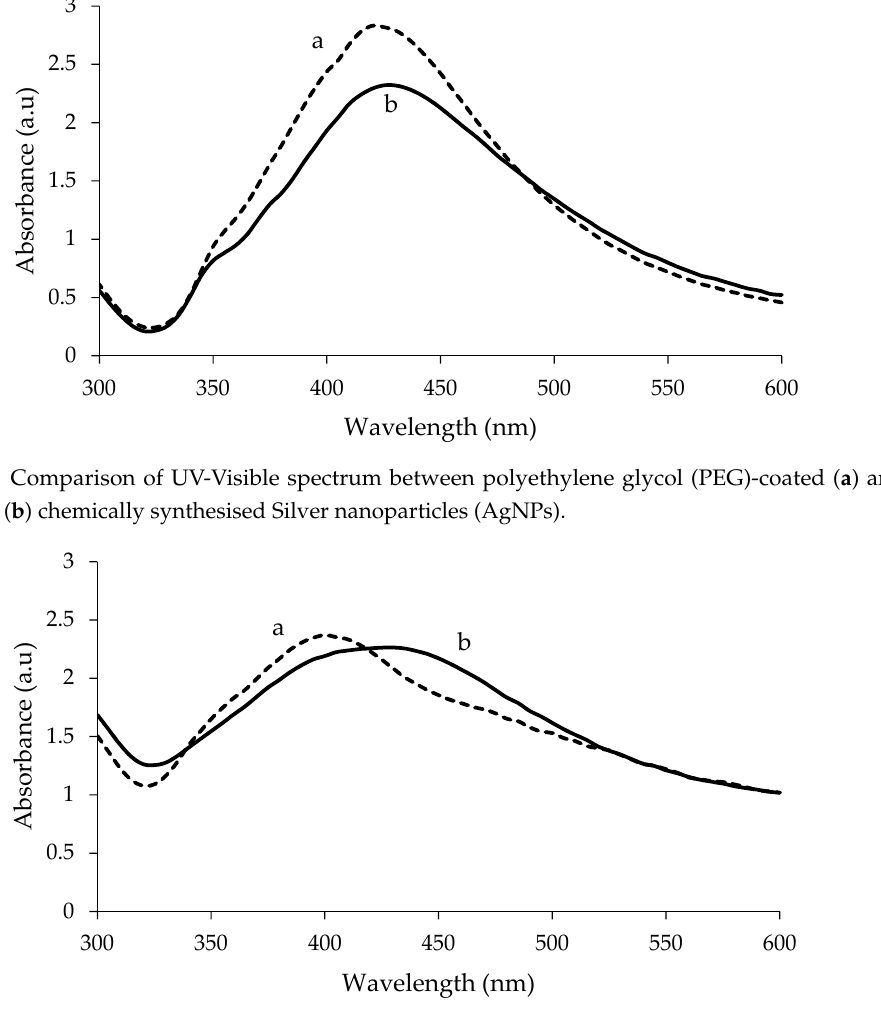
Figure 2. Comparison of UV-Visible spectrum between PEG-coated ( a ) and uncoated ( b ) biologically synthesised AgNPs.